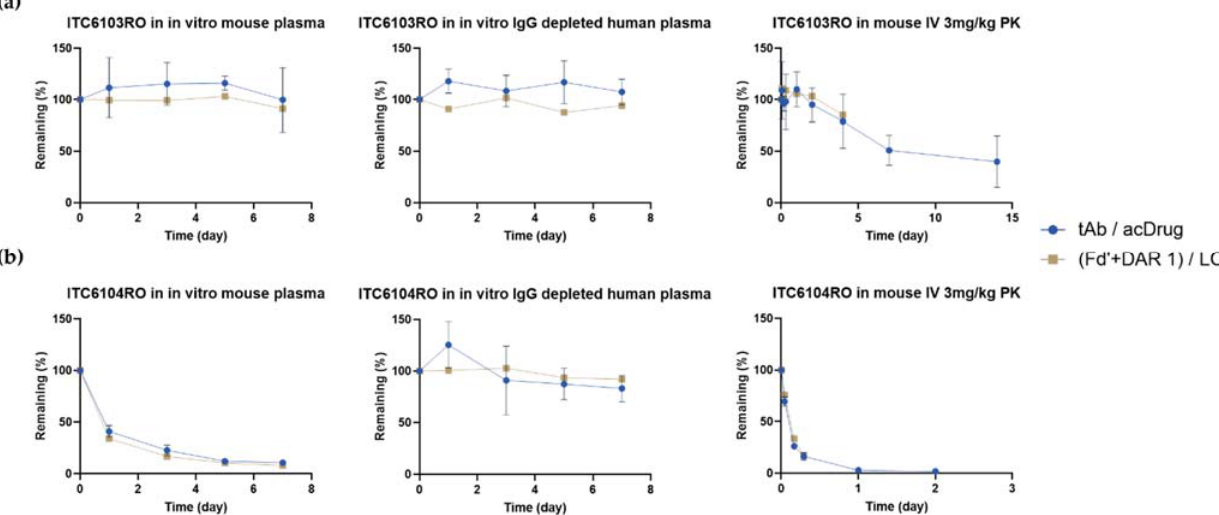
Figure 8. DAR profiles for ( a ) ITC6103RO and ( b ) ITC6104RO from the in vitro linker stability and the in vivo mouse pharmacokinetic samples, respectively.